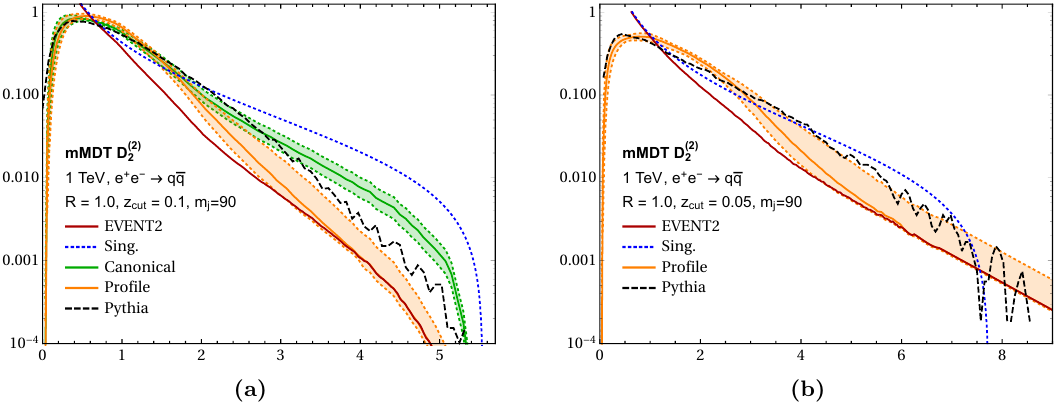
Figure 19. Distributions of D (2)